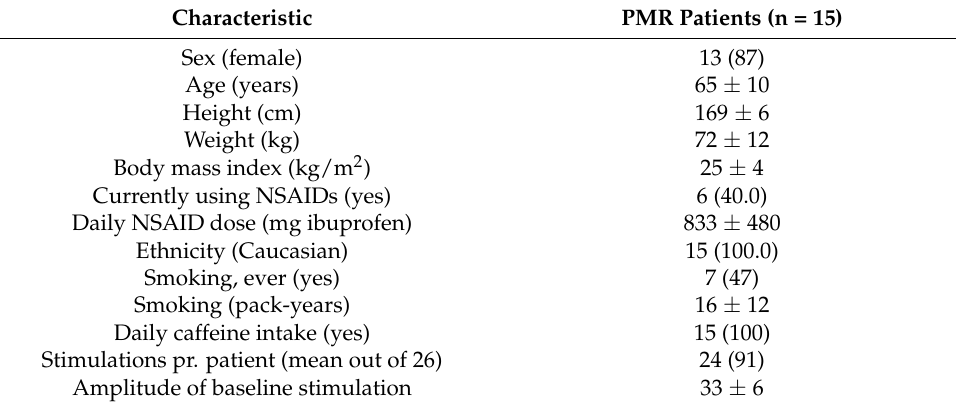
Table 1. Demographic and General Population